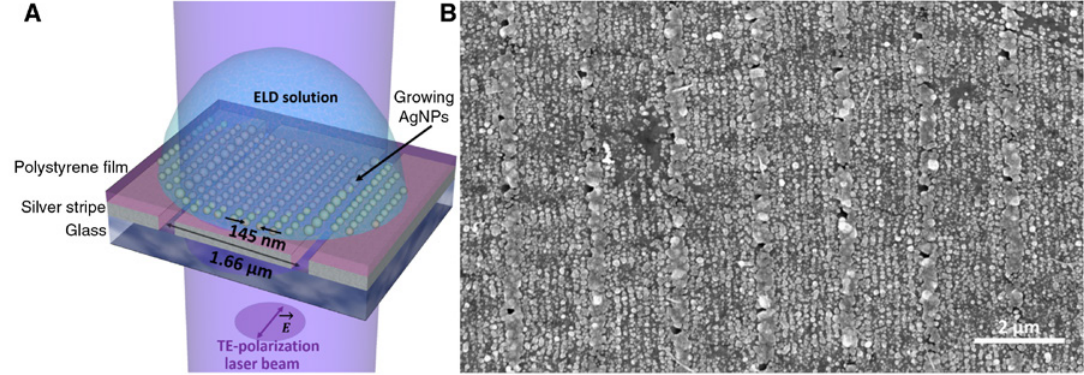
Figure 3: Experimental creation of the optimized hybrid device by growing AgNPs at the local intensity hot spots of the thin film resonator. (A) Schematic illustration of AgNP growth on top of the 180 nm polystyrene film of the thin film resonator. (B) Scanning electron micrographs of the AgNPs on the